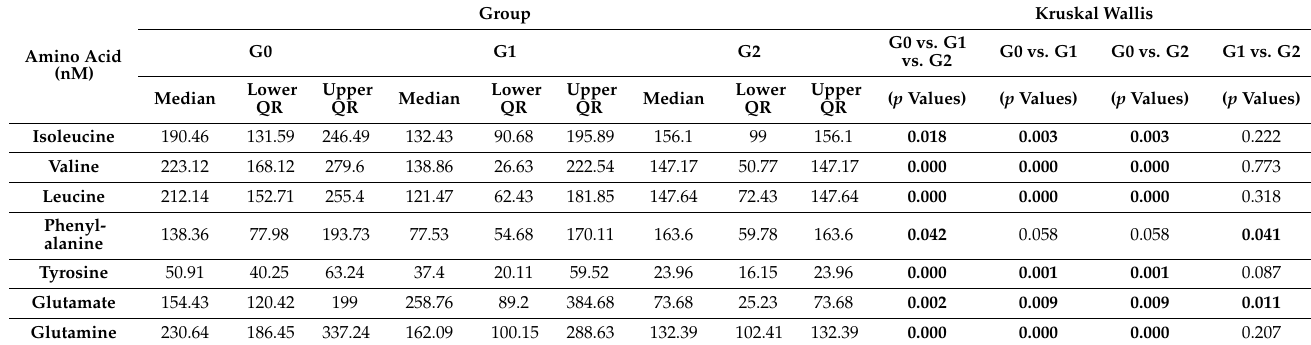
Table 5. BCAA, AAA, glutamate and glutamine comparisons between the healthy controls (G0), single-treated (G1) and multi-treated (G2) type 2 diabetes mellitus groups; data are median (interquartile